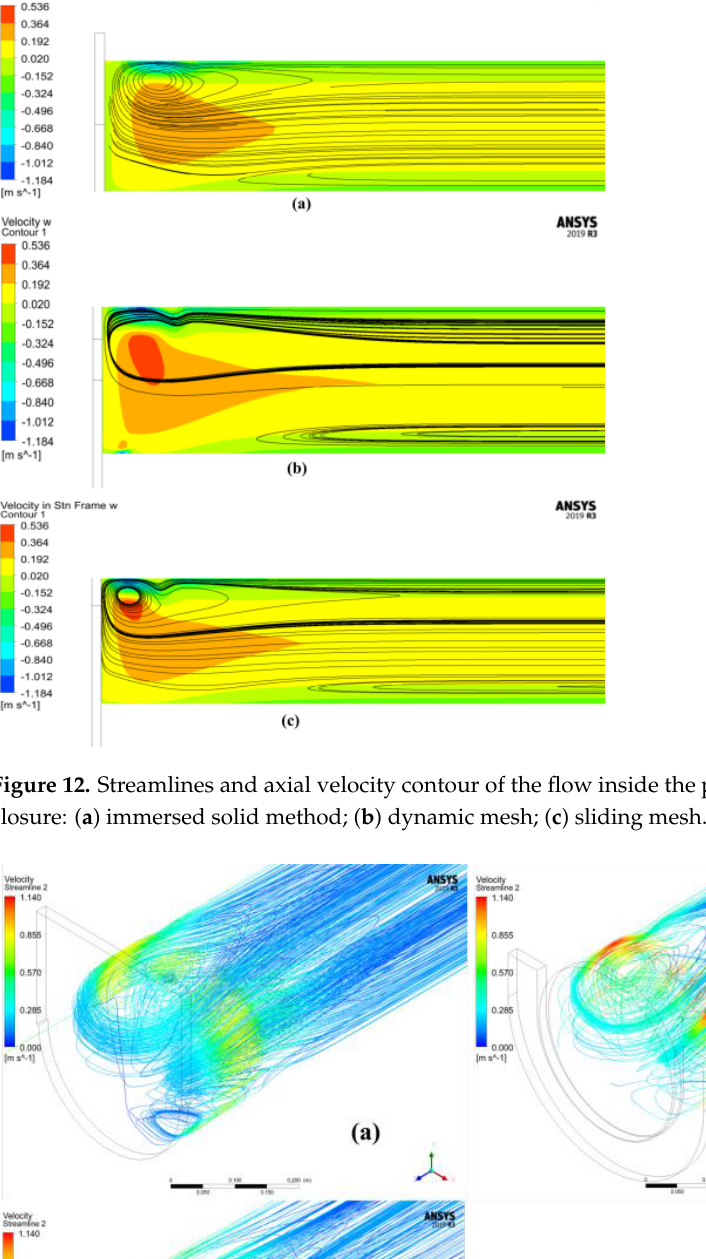
10 of 14 Figure 11. The time variation of the magnitude wall shear stress at cross-sections 10 m upstream of the valve. 3.3. 3D Effects As mentioned, a non-symmetrical recirculation region appears near the gate valve with its movement. Therefore, the flow is 3D close to the valve; however, far from the valve, the flow is 2D. The 3D flow related to the valve closure during the water hammer is visualized by contours of the axial velocity close to the valve at the end of the closure. Streamlines and axial velocity contour of the flow inside the pipe are presented in Figure 12. This non-symmetrical recirculation region extends approximately two to three pipe diameters depending on the simulation method. In Figure 12, the streamlines are pre- sented at time t = 4.75 s; however, the immersed solid method models may have a small time shift regarding the delay in the flow rate reduction. Immersed solid method predicts a shorter length of 3D effect because of possible leakage and weaker water hammer. Dy-